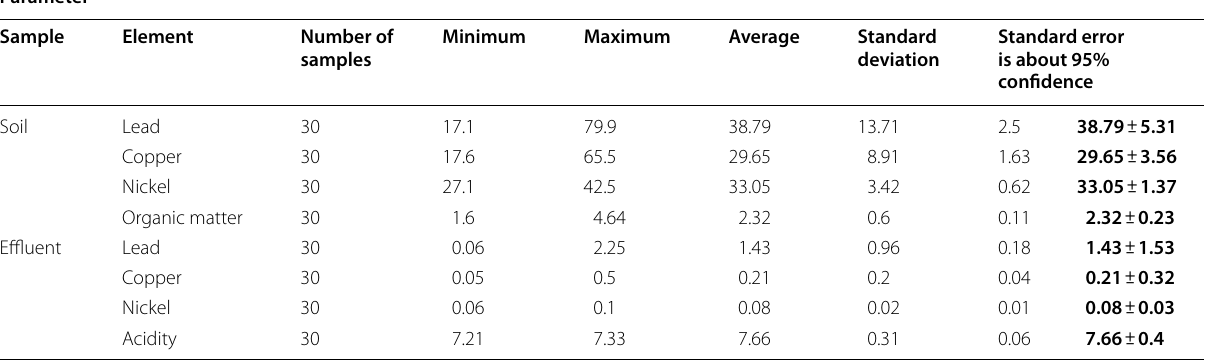
Table 4 Chemical analysis of heavy metal in soil samples Parameter Sample